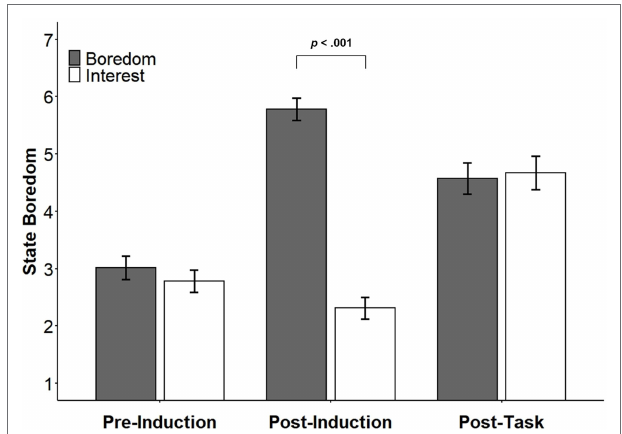
FIGURE 6 | Mean (±SE) ratings of state boredom for those who viewed the boredom or interest induction video. Ratings of boredom were taken before and after the mood induction as well as following completion of the 2-back task. Significant differences between conditions are indicated with brackets above the